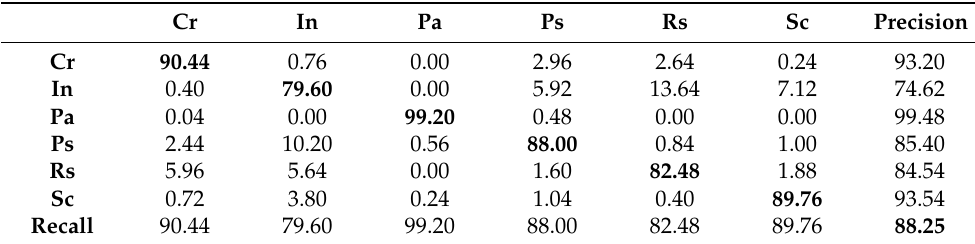
Table 7. The confusion matrices when adopting the MRFFN+IA method on variance 0.3 task containing six types of defects (%), where Cr, In, Pa, PS, RS, and Sc denote the crazing, inclusion, patches, pitted surface, rolled-in scale, and scratches defects respectively.